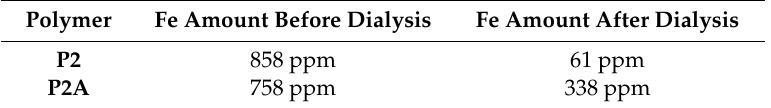
Table 3. Iron concentration obtained from the polymer samples a.